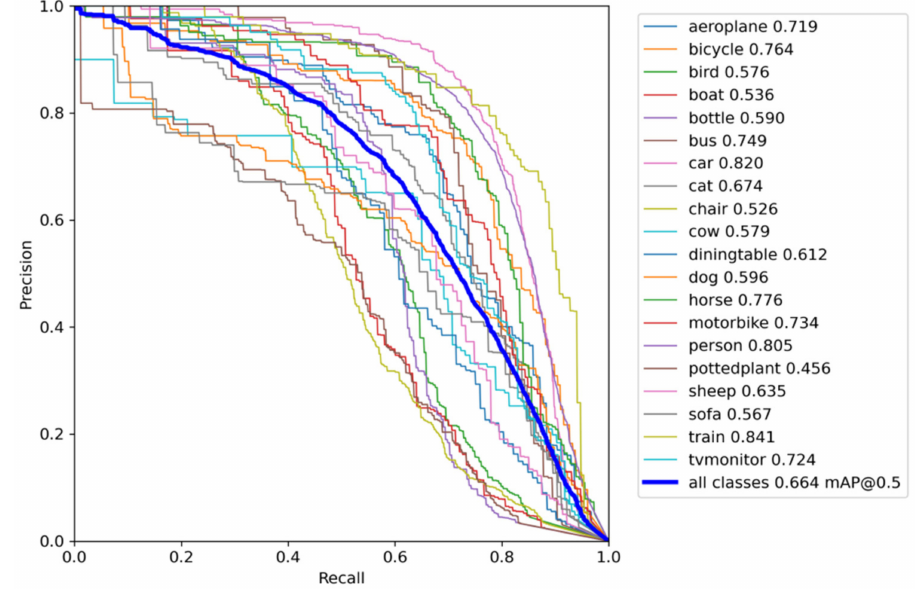
Figure 9. The precision and recall of the YZNet-YOLOV5-tiny (IOU = 0.5).